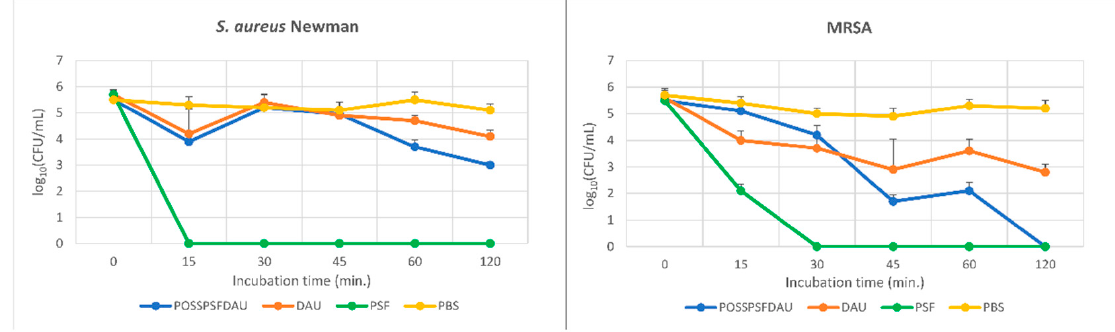
Figure 8. Photodynamic inactivation of MRSA and Newman S. aureus in vitro by POSSPSFDAU conjugate, DAU and PSF dye after irradiation for 5 min ( λ em. max = 522 nm, irradiation = 10.6 mW/cm 2 ).